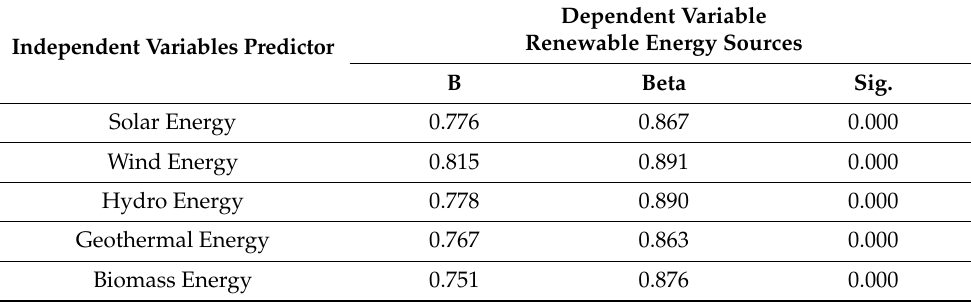
Table 7. Regression analysis of renewable energy sources with